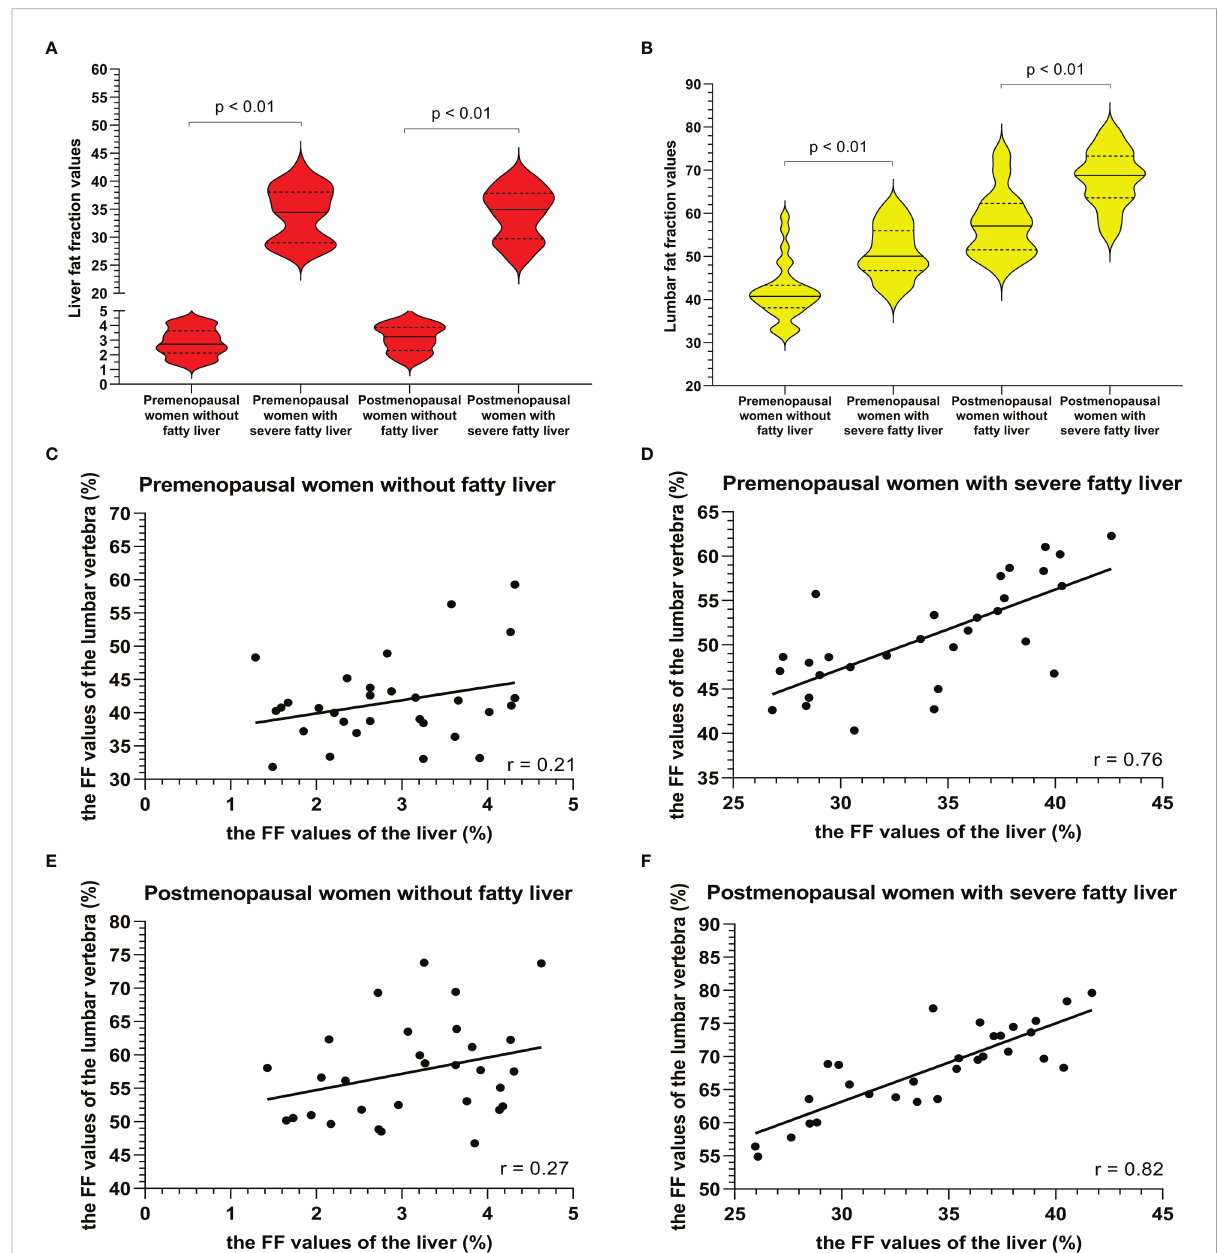
FIGURE 4 The violin plot analyzing the fat fraction values for the liver fat content (A) and lumbar fat content (B) in four groups (premenopausal women without NAFLD, premenopausal women with severe NAFLD, postmenopausal women without NAFLD, and postmenopausal women with severe NAFLD; 30 subjects in each group) con fi rmed that the lumbar fat content of patients with severe NAFLD more than that without NAFLD before menopause ( p < 0.01) and after menopause ( p < 0.01). The correlation plots for the correlations between FF lumbar and the FF liver (C – F) The correlation between FF lumbar and the FF liver in premenopausal (C) or postmenopausal (E) women without NAFLD was no different. A high correlation was detected between FF lumbar and the FF liver in women with severe NAFLD (premenopausal women: r = 0.76, p < 0.01; postmenopausal women: r = 0.82, p < 0.01) (D, F)